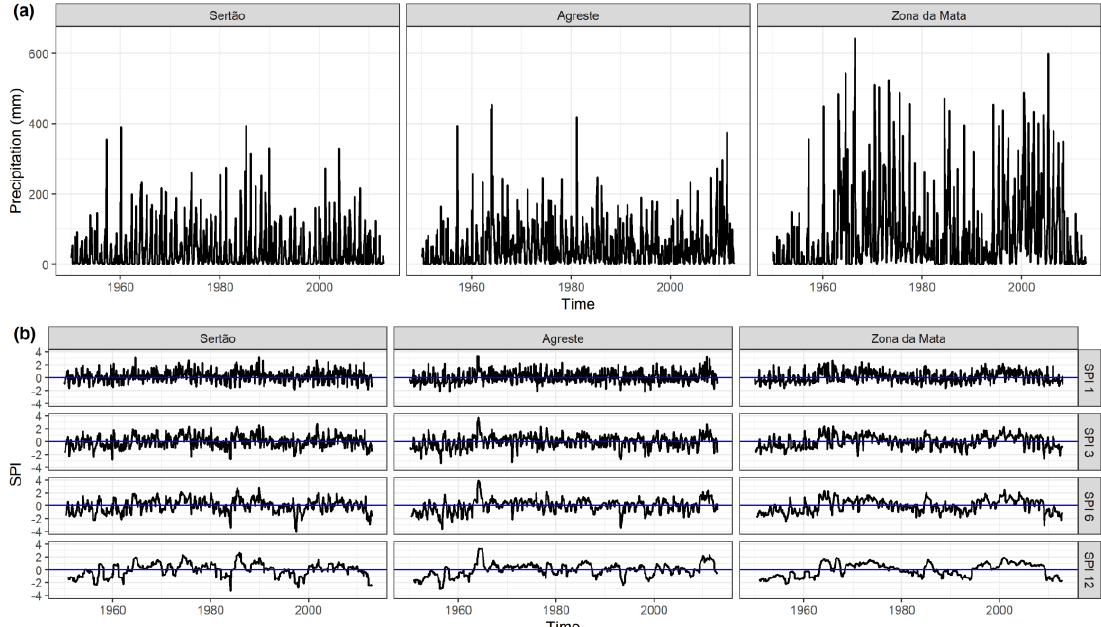
Figure 3. Monthly precipitation ( a ) and SPI values ( b ) at different time scales (SPI-1, SPI-3, SPI-6 and SP-12), for representative stations of the three regions.